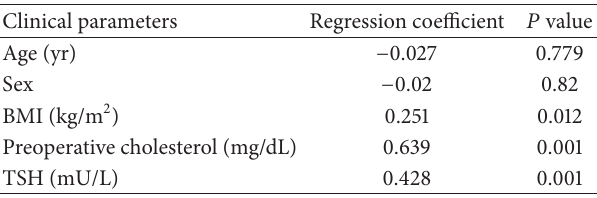
Table 5: Multiple logistic analyses with total cholesterol level following thyroid hormone withdrawal as a dependent